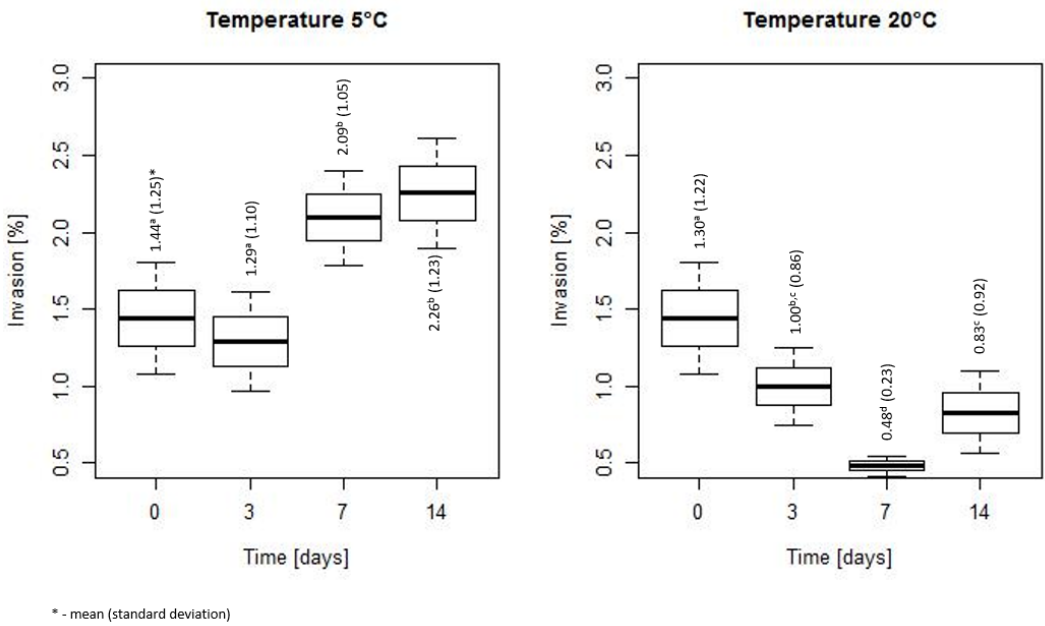
Figure 7. The invasiveness of bacteria during a storage at 5 and 20 °C (the horizontal line is the mean, the box spans represent standard error and the whiskers represent 95% confidence interval).